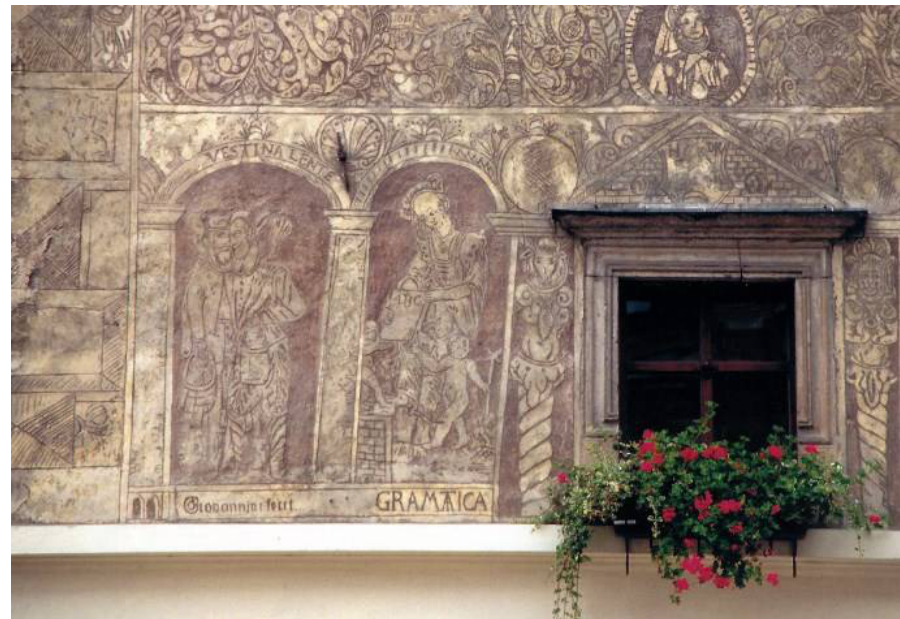
Figure 33. Sgraffito decorations at the Scholz House in Legnica. In the niche on the left, the self- portraits of the contractors (master Giovannini and his assistant), on the right, the personification of Grammar. Author’s photo, 2003.